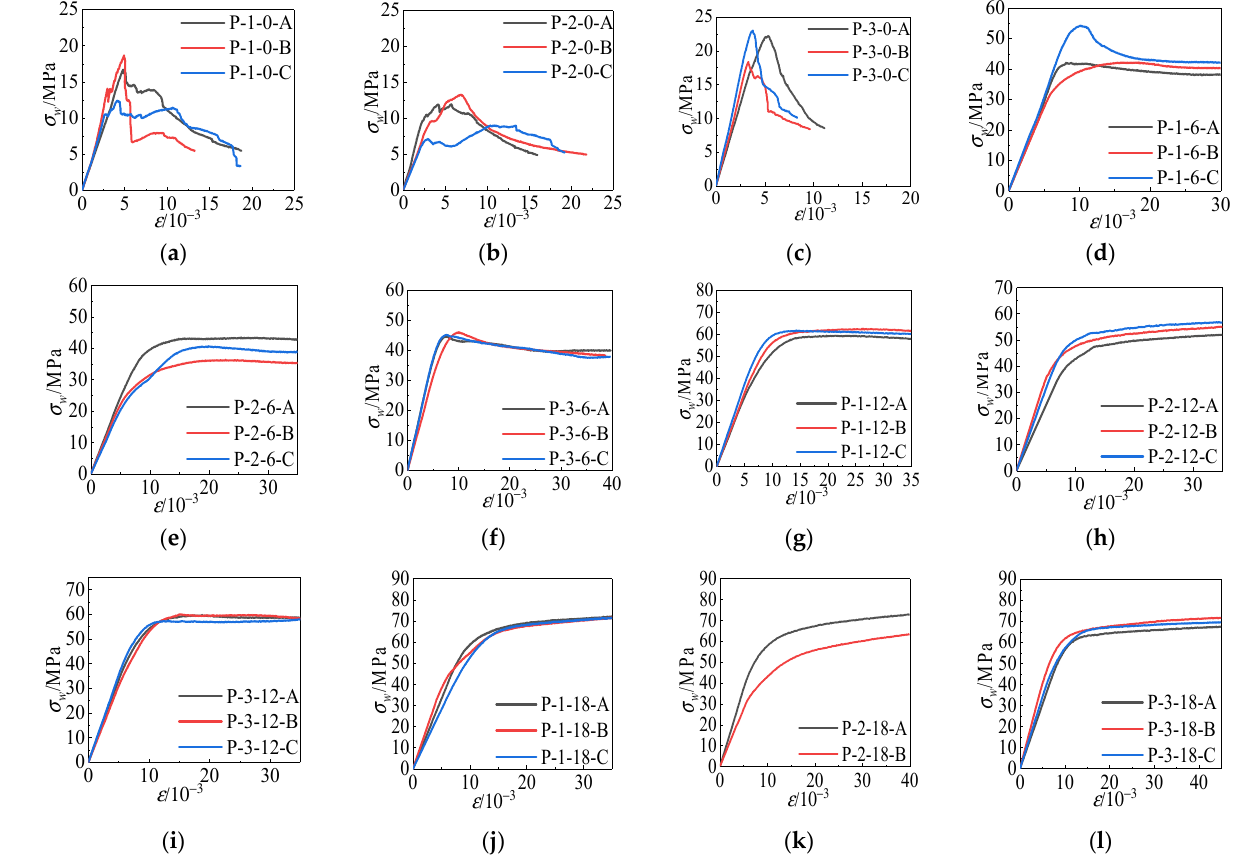
Figure 11. Full stress–strain curve of specimen. ( a ) PF-1-0, ( b ) PF-2-0, ( c ) PF-3-0, ( d ) PF-1-6, ( e ) PF-2- 6, ( f ) PF-3-6, ( g ) PF-1-12, ( h ) PF-2-12, ( i ) PF-3-12, ( j ) PF-1-18, ( k ) PF-2-18, ( l ) PF-3-18.